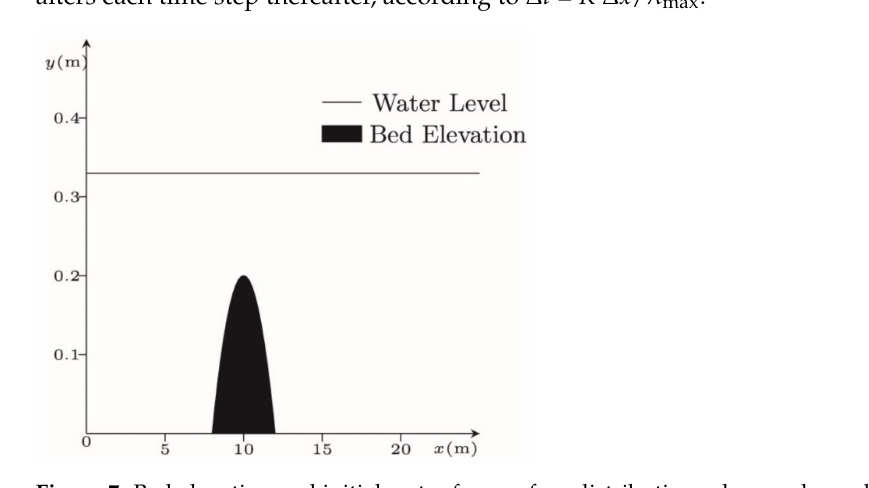
Figure 7. Bed elevation and initial water free surface distributions along a channel for the case of Figure 8. Analytical steady-state free surface elevation distribution [24] along a channel for the case transcritical flow over a bed of transcritical flow over a bed hump.